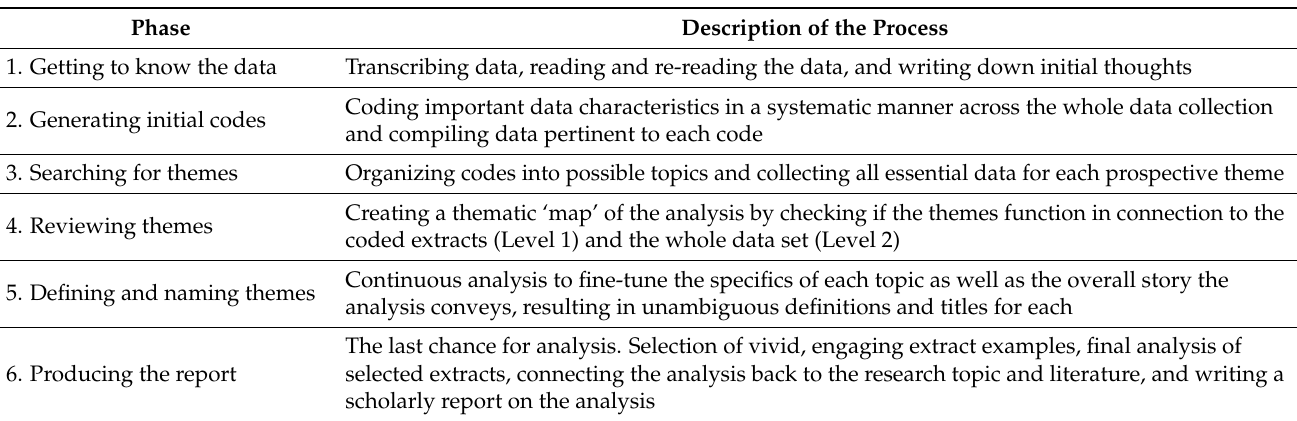
Table 3. Phases of the thematic